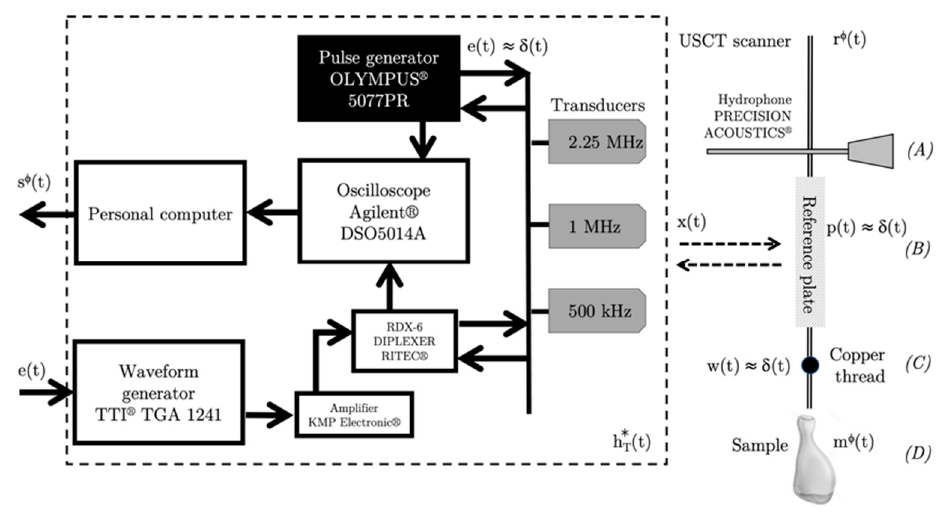
Figure 5. Synoptic view of the data acquisition and electro-acoustic setup.